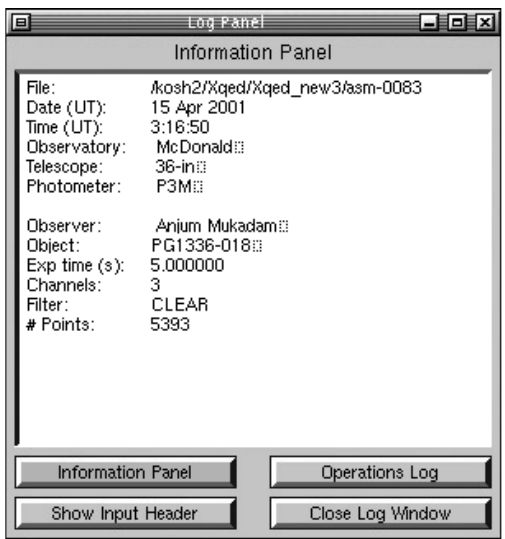
Fig. 3. The XQED log